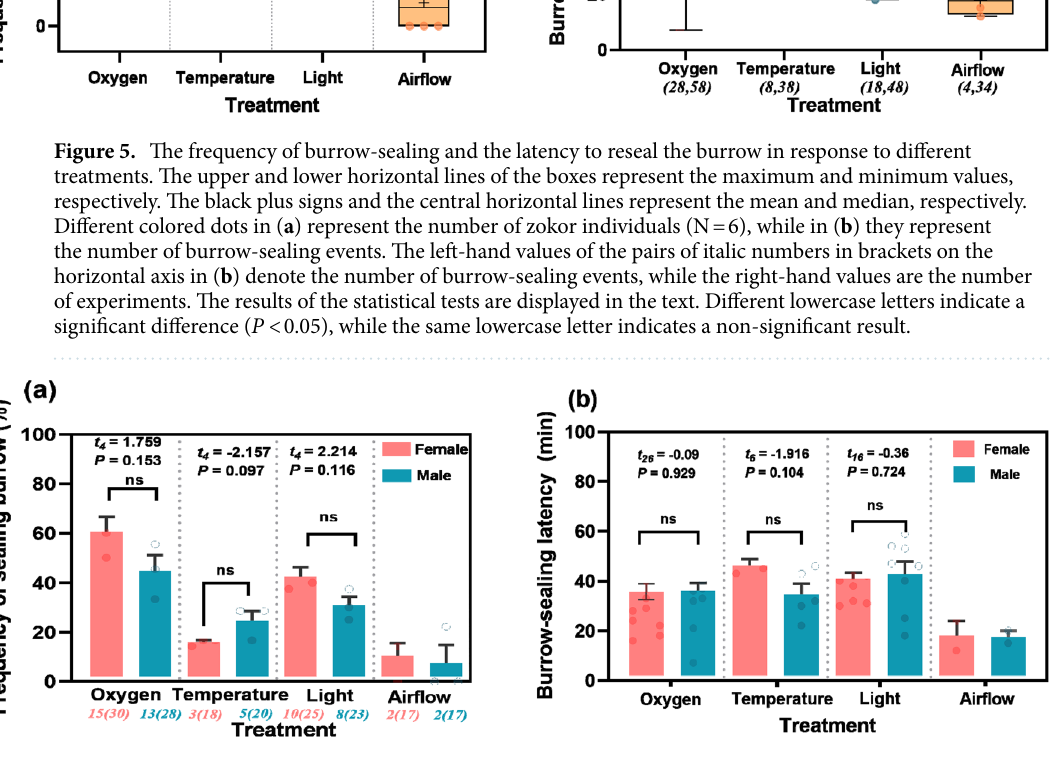
Figure 6. The frequency of burrow-sealing and the latency to reseal the burrow in response to different treatments between the sexes. The results of independent-samples T-tests for the differences ( P < 0.05) between females (N = 3) and males (N = 3) are displayed. Pink bars and blue bars represent females and males, respectively; and pink and blue dots in ( b ) represent the number of occurrences of sealing burrows in females and males, respectively. The italic numbers on the horizontal axis in ( a ) refer to the number of burrow-sealing events (numbers not in brackets) and the number of experiments (numbers in brackets), and “ns” in both panels denotes